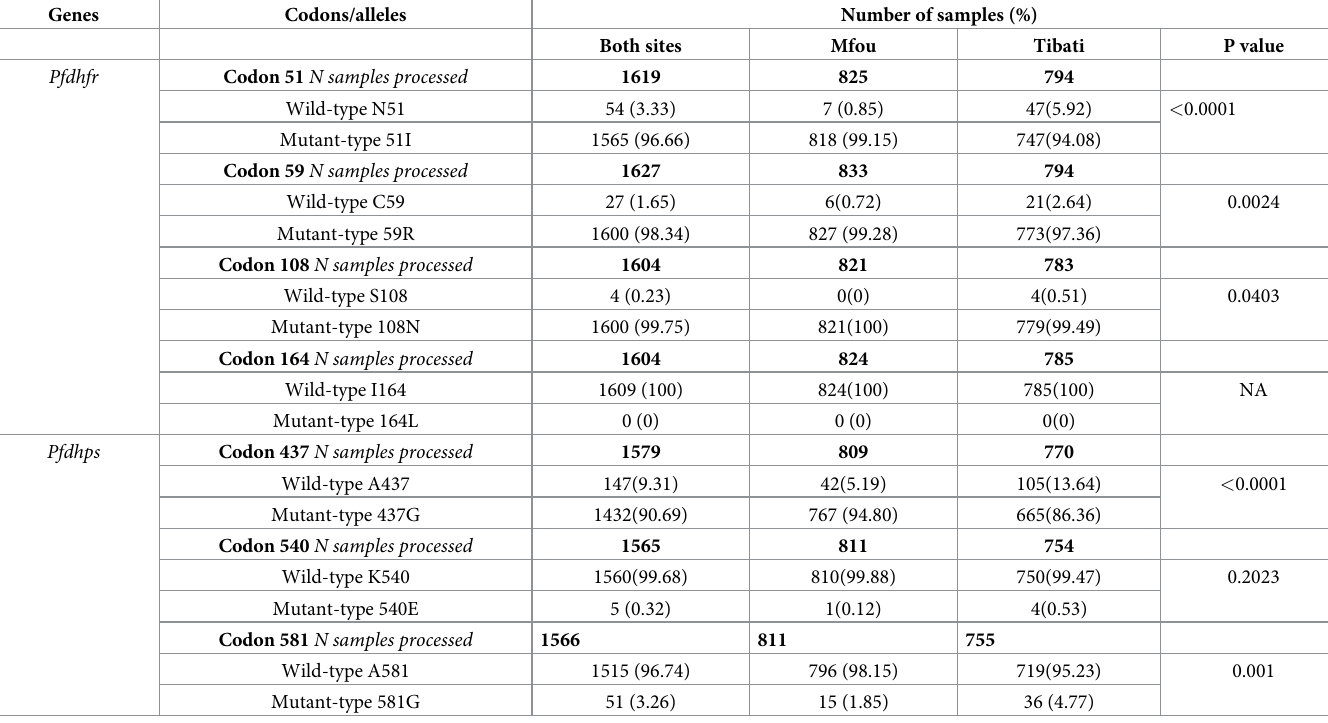
The distribution of alleles at each SNP was compared between Mfou and Tibati using a Chi square test and the P-value is indicated. NA, not